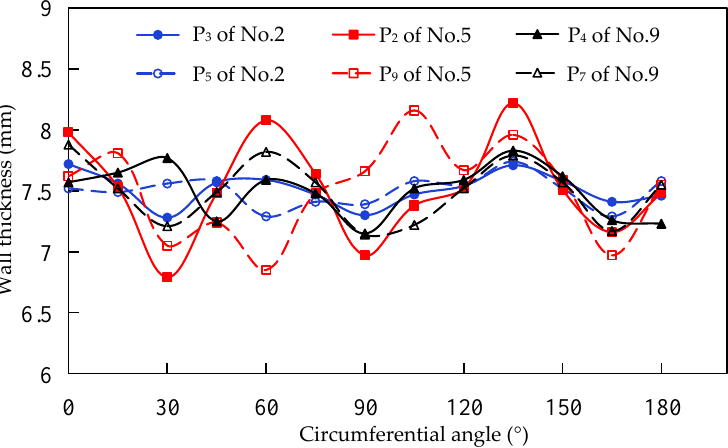
Figure 4. Circumferential wall thickness distribution. (1) The wall thickness along the circumferential direction is alternately thin and thick, such as the wall thickness of P 3 and P 5 cross-section of No.2 tube, P 2 and P 9 cross- section of No.5 tube, P 4 and P 7 cross-section of No.9 tube all varies alternately from 0 ◦ to 180 ◦ . The absolute value of the maximum positive and negative deviation wall thickness on the same cross-section is close. Such as the maximum positive and negative deviation wall thickness of P 3 cross-section of No.2 tube is 0.35 mm and − 0.33 mm, respectively, P 2 cross-section of No.5 tube is 0.62 mm and − 0.65 mm, respectively, P 7 cross-section of No.9 tube is 0.40 mm and − 0.42 mm, respectively.